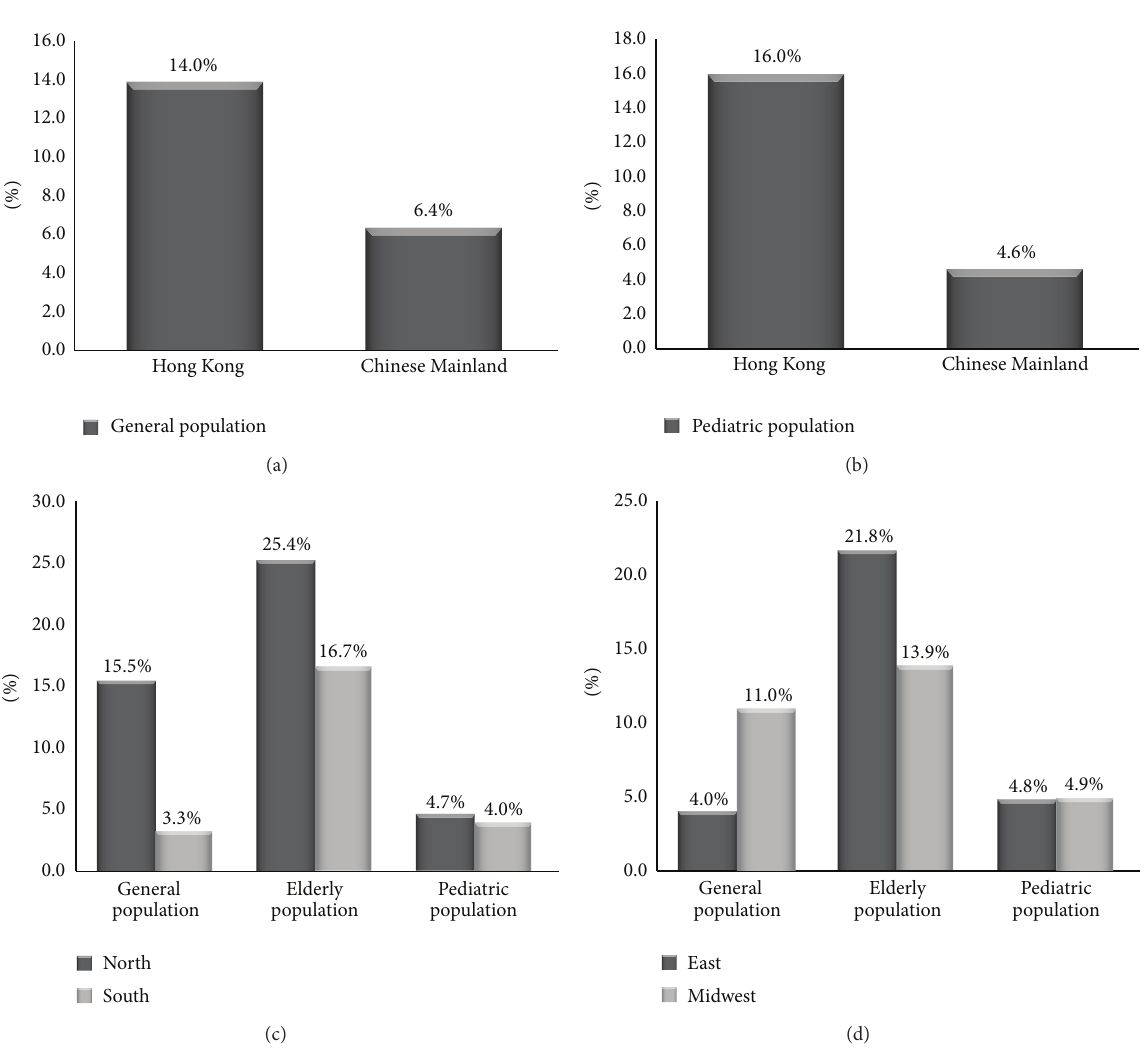
Figure 2: Regional difference in the prevalence of constipation. (a) In general population, the prevalence rate of constipation in Hong Kong was higher than that in Chinese Mainland. (b) In pediatric population, the prevalence rate of constipation in Hong Kong was higher than that in Chinese Mainland. (c) Prevalence rate of constipation in Northern area was significantly higher than that in Southern area in general populationandelderlypopulation,whiletherewasnosignificantdifferencebetweenNorthernareaandSouthernareainpediatricpopulation. (d)PrevalencerateofconstipationinEasternareawassignificantlylowerthanthatinMidwesternareaingeneralpopulation,whileprevalence rateinEasternareawassignificantlyhigherthanthatinMidwesternareainelderlypopulation,andtherewasnosignificantdifferencebetween Eastern area and Midwestern area in pediatric